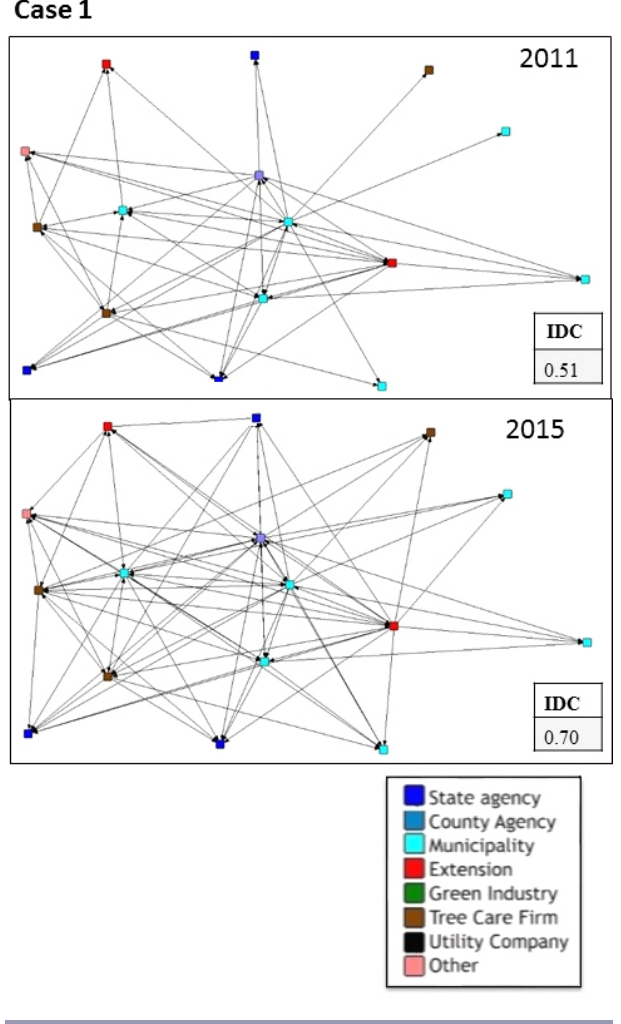
Fig. 1 . Changes in degree centrality (IDC), normalized to group size and network map of emerald ash borer (EAB) task force, Case 1. Note: IDC value refers to mean in-degree centrality.